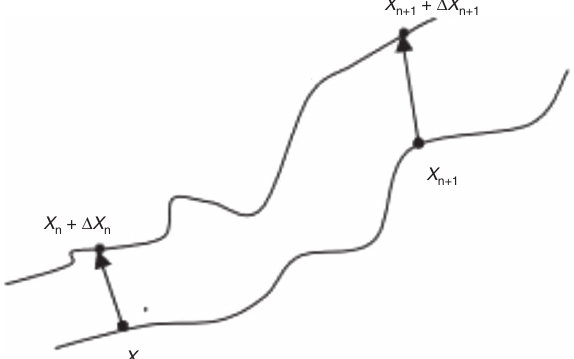
Figure 2: Lyapunov